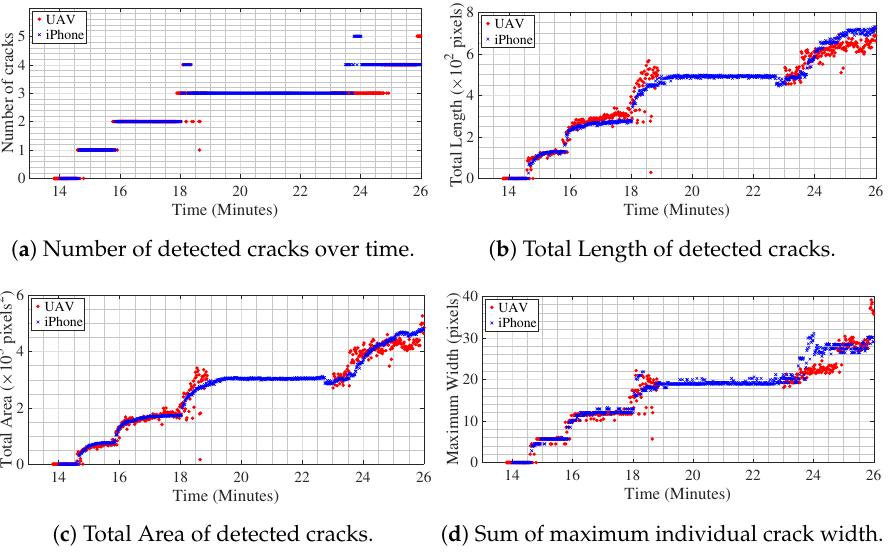
Figure 8. Variation of crack characteristics with time (red filled-in circles for UAV video and blue crosses for iPhone